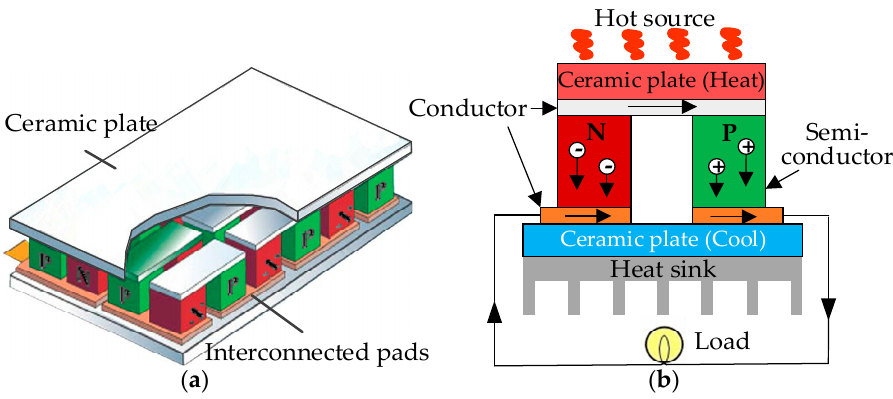
Figure 9. Thermoelectric generators: ( a ) Typical structure; ( b ) Seebeck effect.